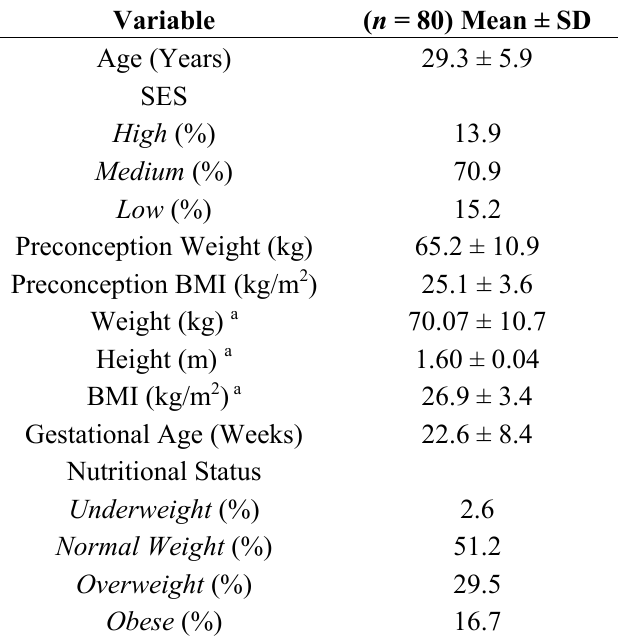
Table 1. Background